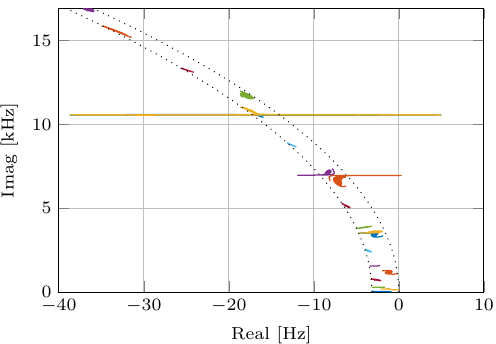
Figure 4. Locus plot of the 20 lowest eigenvalues for a friction coefficient µ = 0.3.